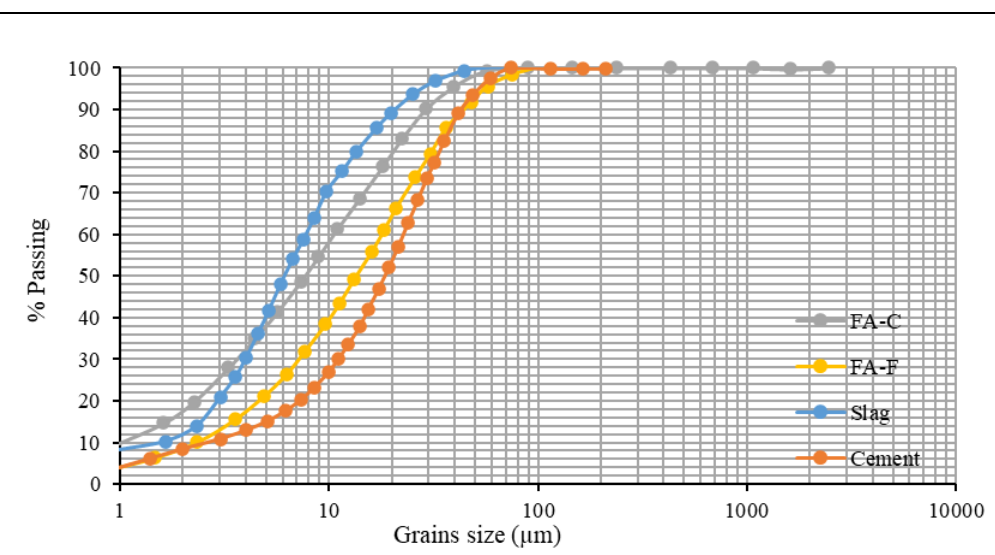
Figure 1. Grain size gradation of supplementary cementitious materials (SCMs) and cement.